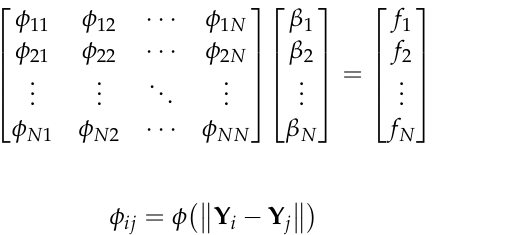
where r is the displacement of the grid node; Y is the coordinate vector of the grid node; β i is the interpolation coefficient; φ is the basis function. (cid:107) Y − Y i (cid:107) is the distance between two grid nodes, expressed as